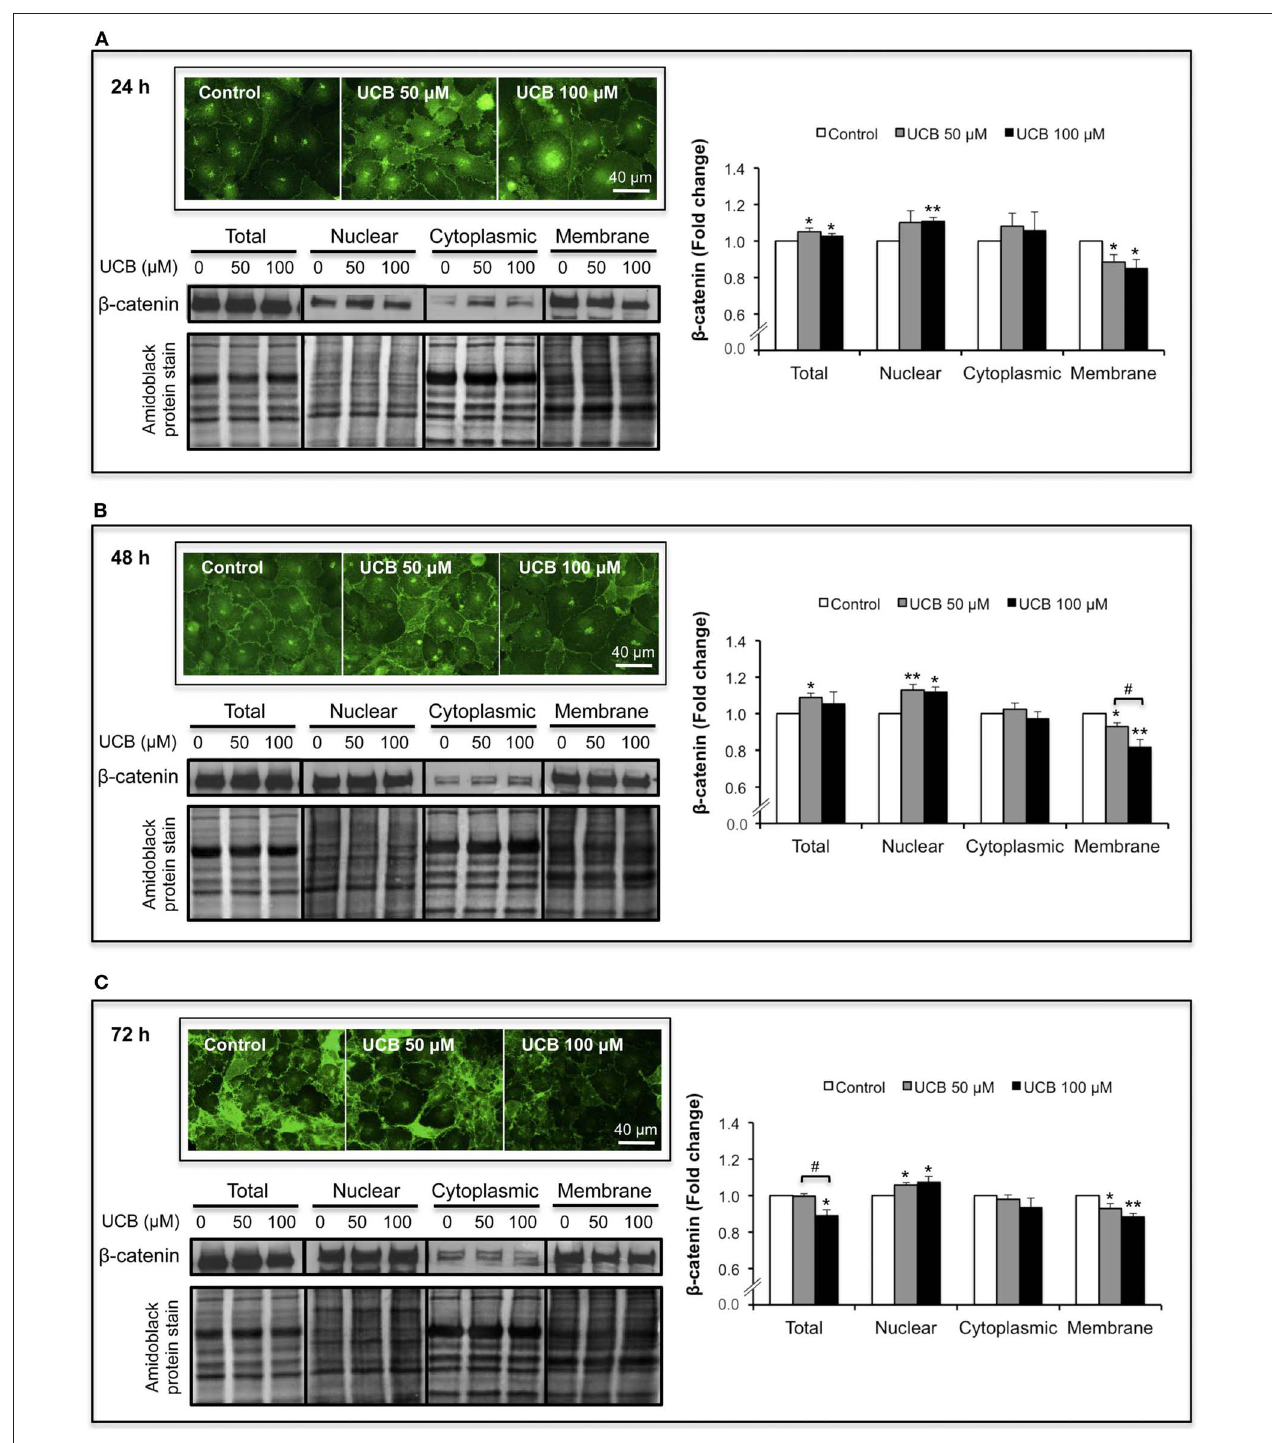
FIGURE 4 | UCB interaction with the HBMEC monolayer determines an upregulation of nuclear β -catenin and a down-regulation in the membrane fraction. HBMEC line was incubated without (control) or with 50 or 100 μ M UCB, in the presence of 100 μ M HSA. β -catenin was evaluated by immunofluorescence and Western blot analysis of different subcellular locations (nucleus, cytoplasm, and membrane), after subcellular fractionation. Representative immunofluorescence photos, as well as